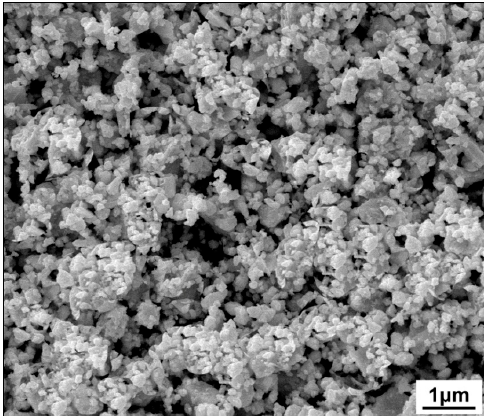
Figure 2. SEM image of the 1.6 vol % C 60 /Cu 2 SnSe 3 powder after ball milling.